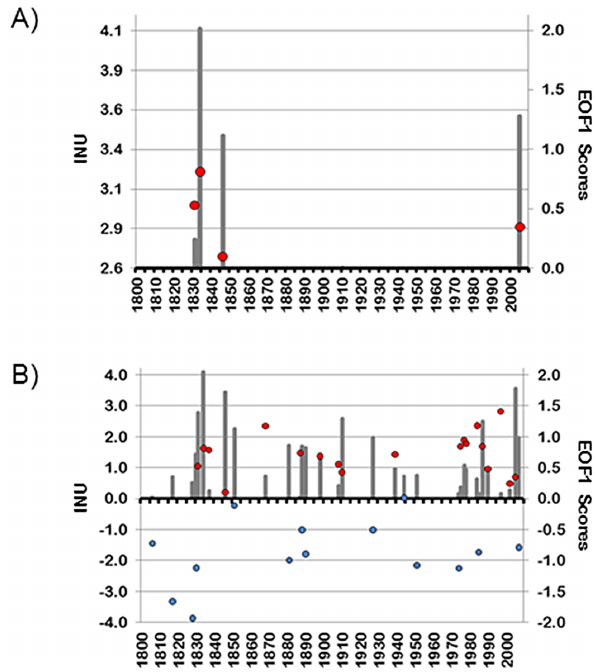
Figure 7. (a) Summer flood damage index INU (bars) versus posi- tive phase of EOF1 (red dots) for values of INU 5 times greater than the standard deviation (INU >5 SD). (b) As in (a) but for the com- plete signal of the INU. Blue dots represents negative EOF phase.